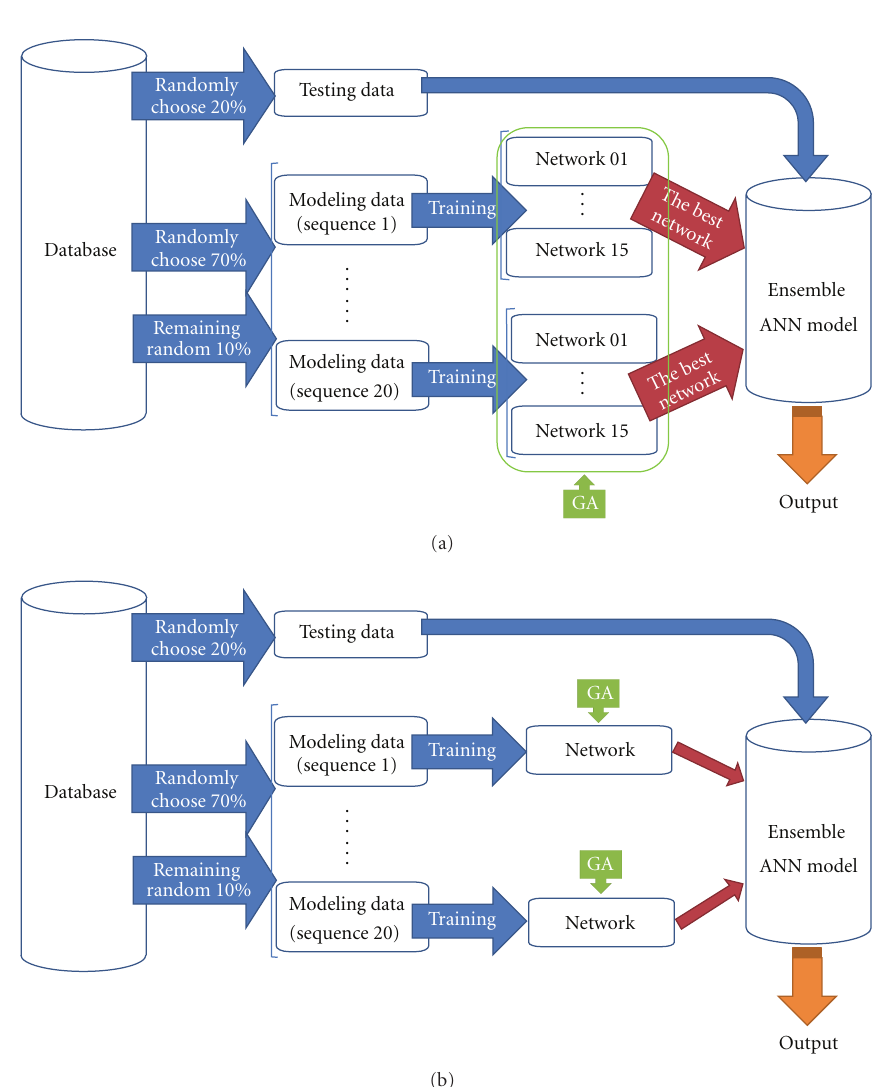
Figure 3: The skeleton with GA-based initial weights: (a) type 1 and (b) type